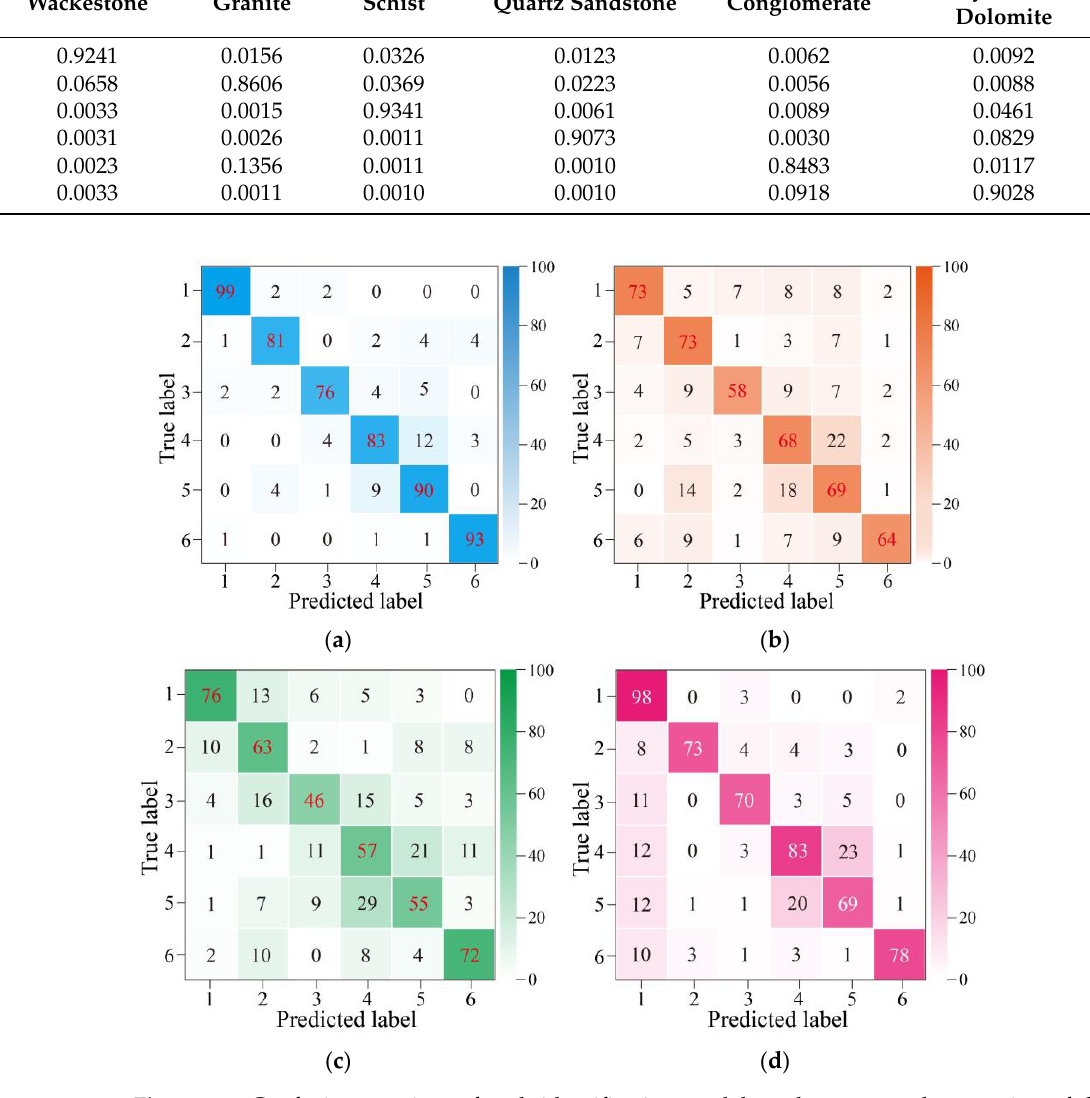
Table 4. Identification probability of rock images in Figure 14, the meaning of digits: 1- wackestone,